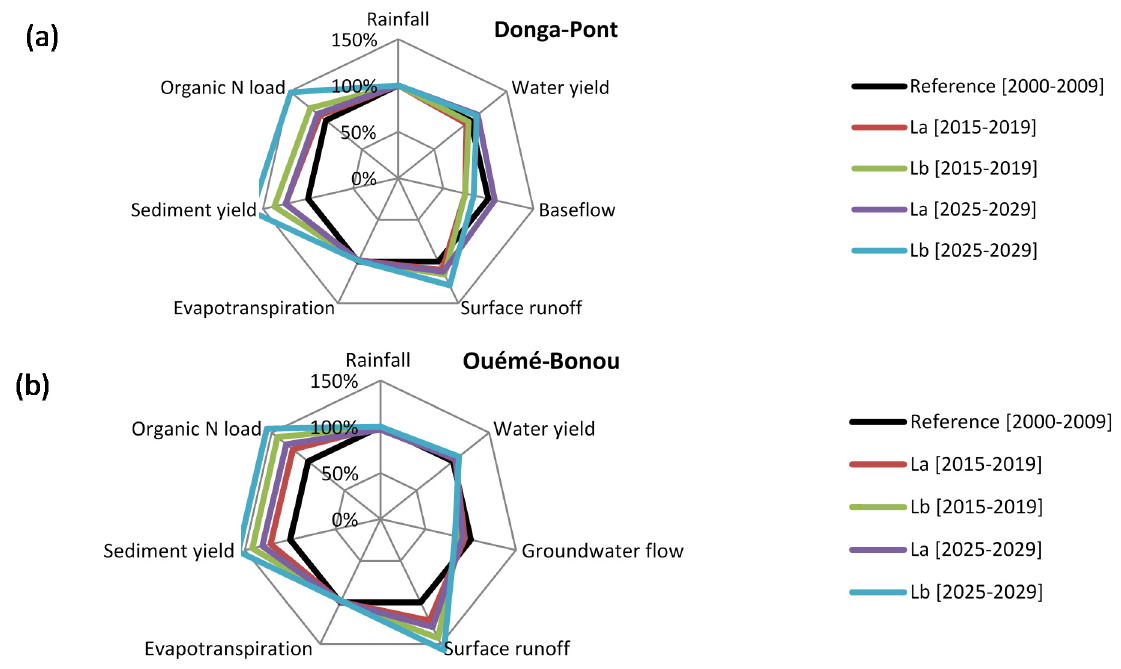
Figure 12. Simulated trends under land use scenarios (with unchanged climate: 2000–2009). ( a ) Donga-Pont; ( b )